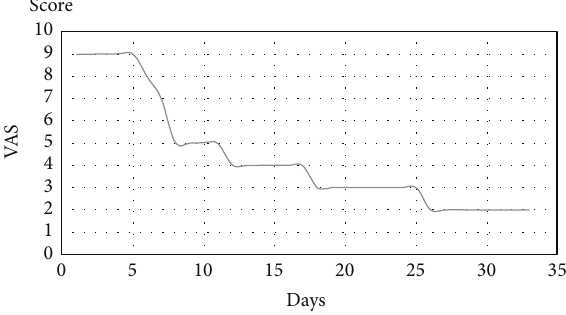
Figure 7: VAS score during